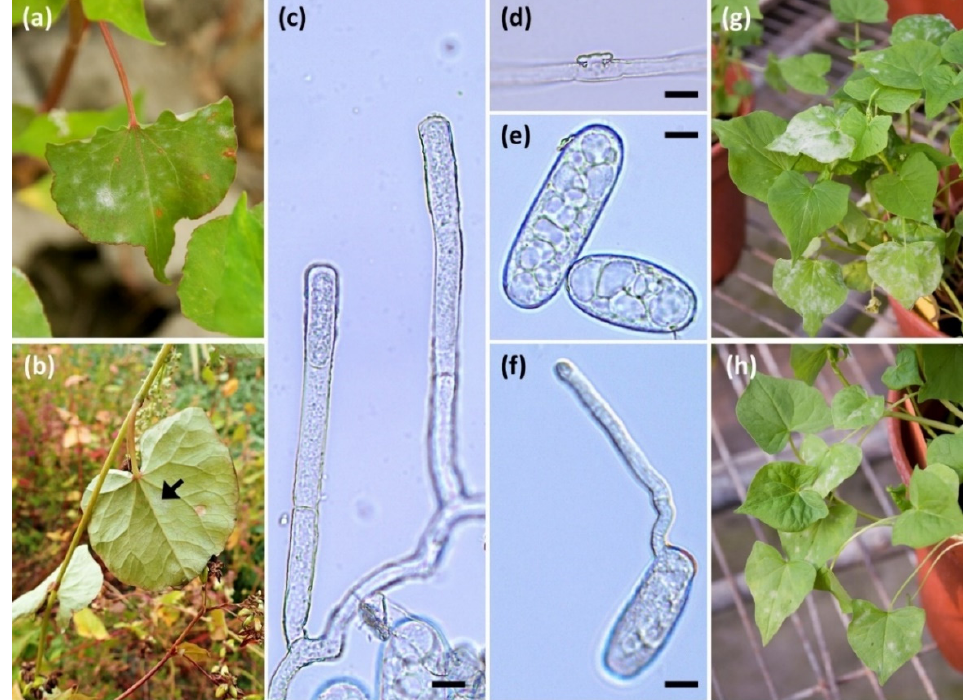
Figure 5. Erysiphe aff. betae on Fagopyrum spp. ( a – b ) Symptoms of the powdery mildew on naturally infected plant F. esculentum and F. tataricum in field, respectively. Arrow indicates the symptoms of the powdery mildew. ( c – f ) Micrographs of E. aff. betae on F. esculentum TNM 0034604. ( c ) Conidiophores with conidia. ( d ) Hyphal appressorium. ( e ) Conidia. ( f ) Conidium with germ tube. ( g ) The symptoms on F. esculentum inoculated with E. aff. betae on F. esculentum . ( h ) The symptoms on F. tataricum inoculated with E. aff. betae on F. esculentum . Scale bars in ( c – f ) = 10 μ m.